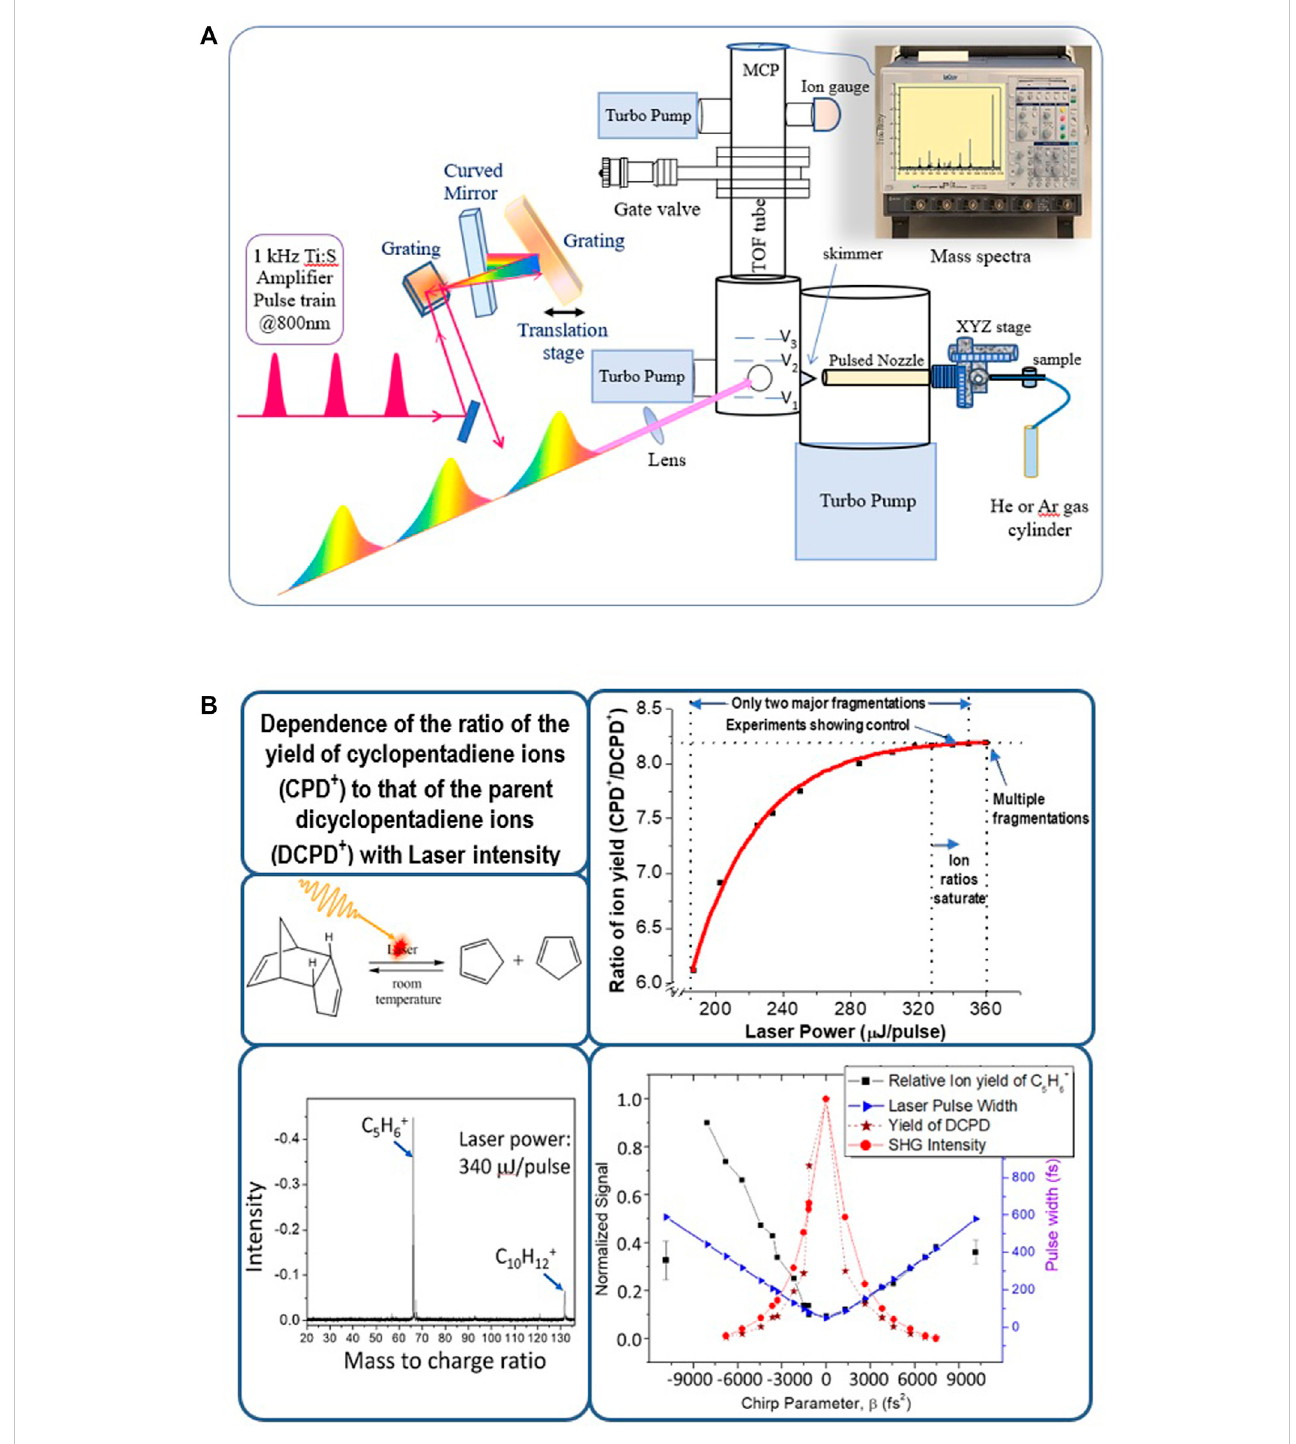
FIGURE 1 (A) Schematic diagram of control experiments with molecular beams with linearly shaped ampli fi ed laser pulses. In (B) , the speci fi c case of laser photo- fragmentation control of dicyclopentadiene is shown. The data here show that the negatively chirped laser pulses (with negative chirp parameter, β ) enhance the fragmentation of dicyclopentadiene to